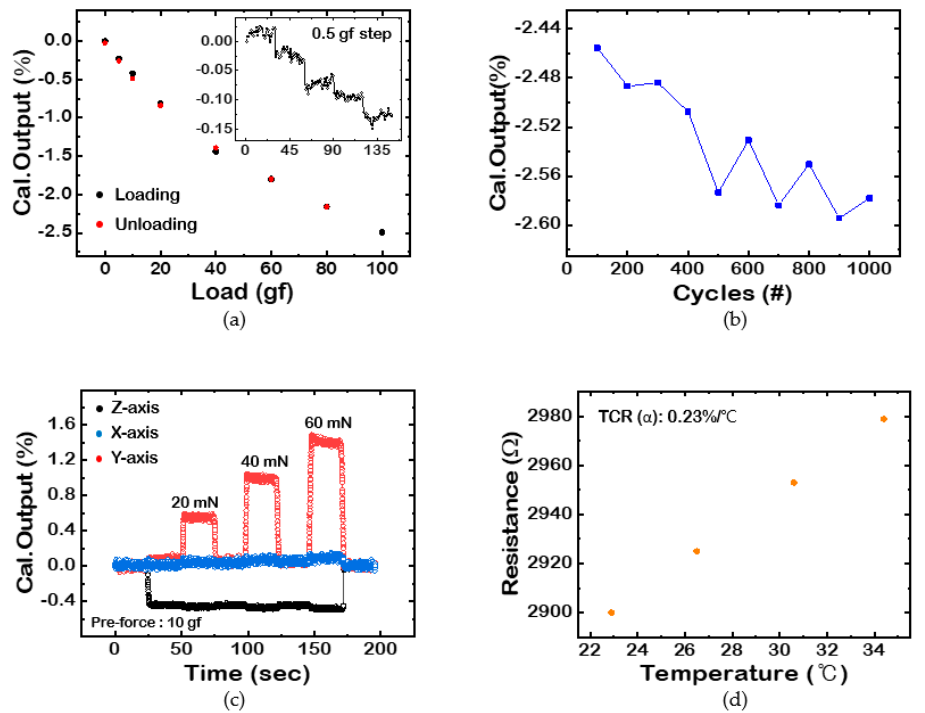
Figure 6. Multimodal sensing characteristics of the tactile sensor: ( a ) Output data about hysteresis characteristic and sensing range. (Inset) Sensor resolution data according to 0.5 g step force. ( b ) One- thousand repeated measurement data at maximum sensing normal force (100 gf). ( c ) 3-axis force data related to the shear force vector generated by a 20 μ m step motion in the Y-axis direction. ( d ) Temperature sensor characteristics for the temperature range from room temperature (23 °C ) to human body temperature (35 °C ).